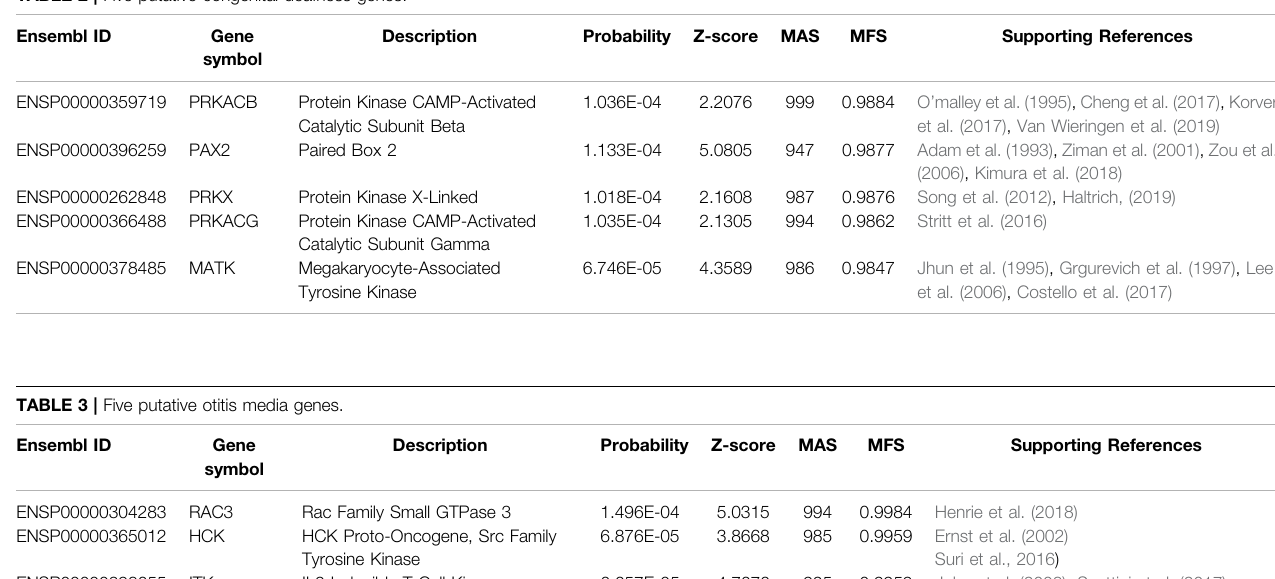
TABLE 2 | Five putative congenital deafness genes.